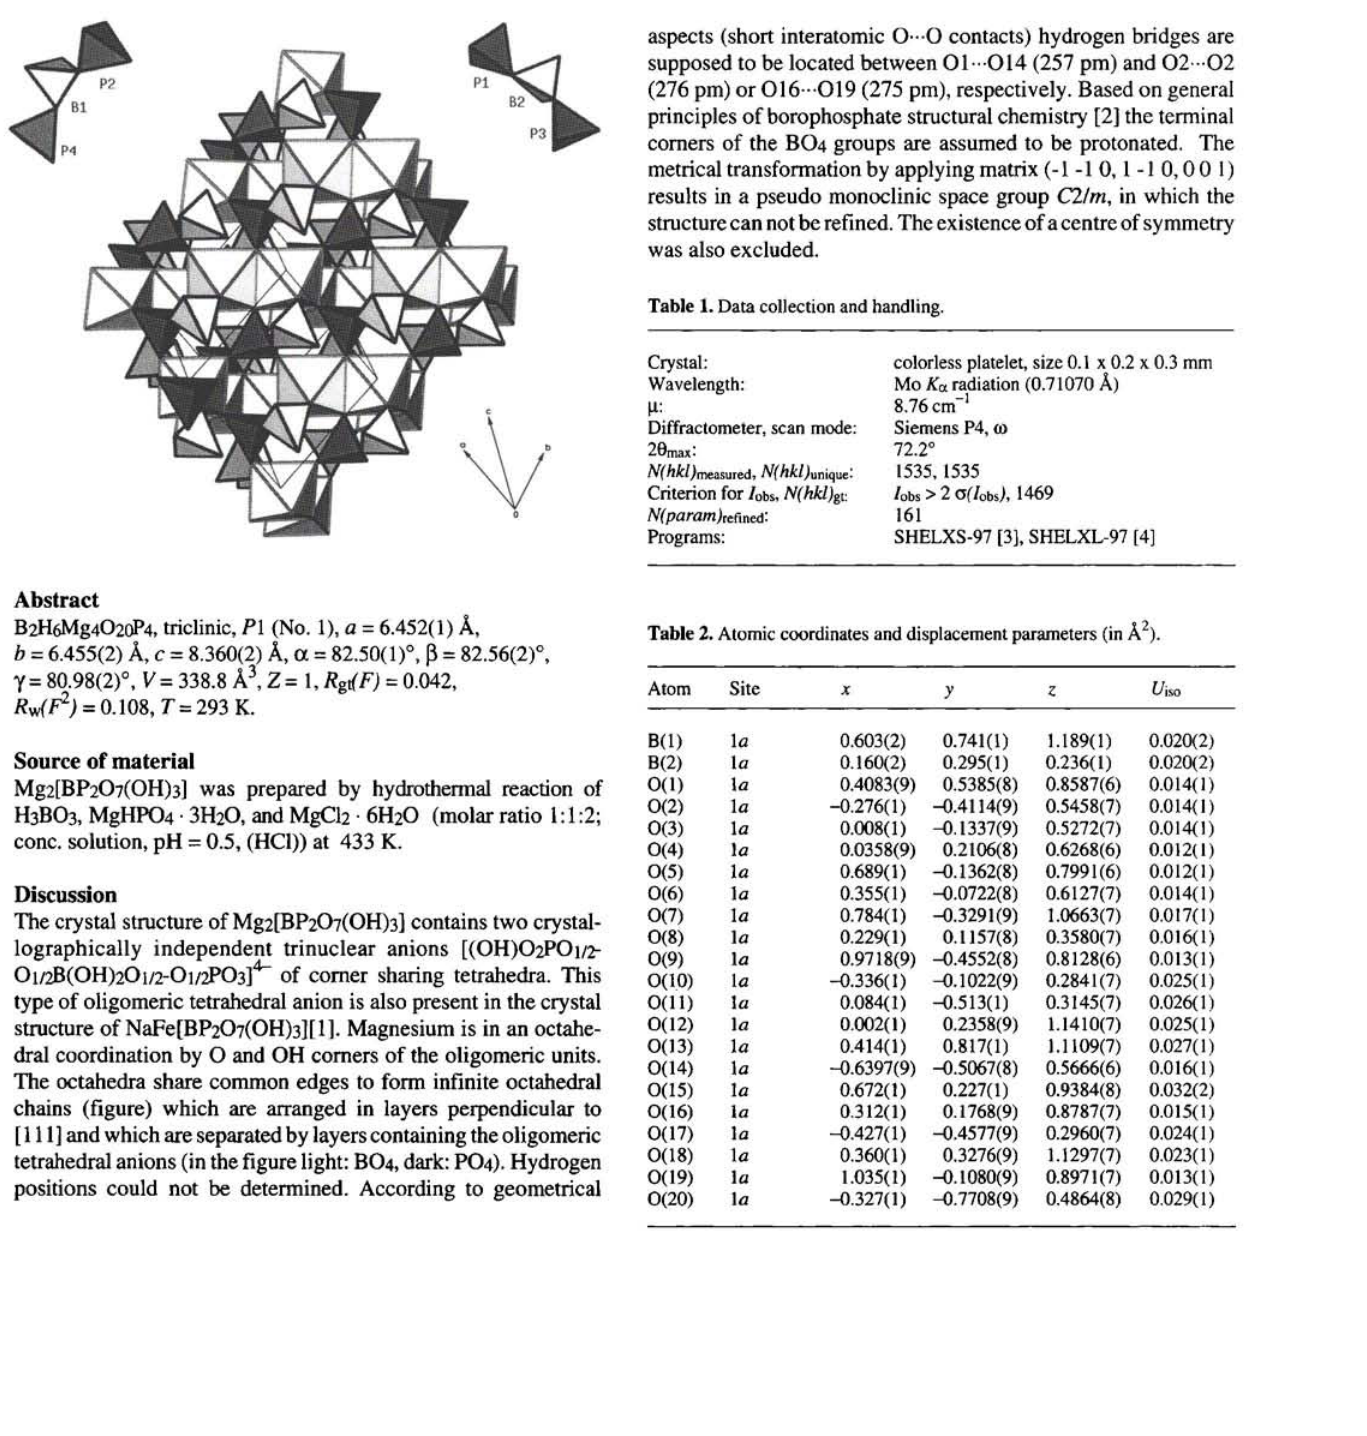
Table 1. Data collection and handling.